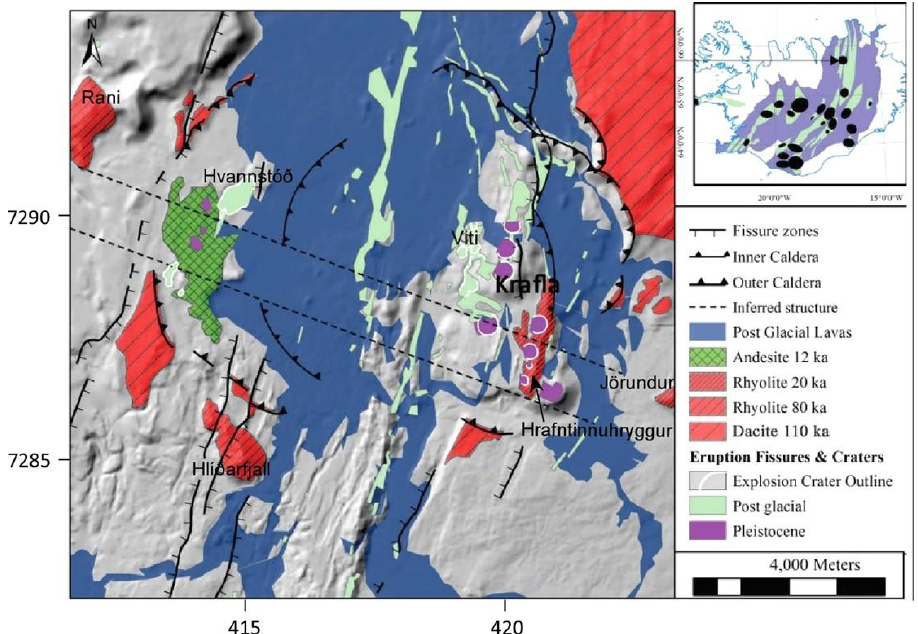
Figure 3. A simplified geological map of Krafla. The map also shows inferred structural features discussed in this paper. Note the abundant explosion craters in the western slopes and south of Mt. Krafla. In the upper right inlet, black dots are volcanos and green strips represent fissure swarms. Coordinates are UTM WGS84 in km. (Modified from [9]).